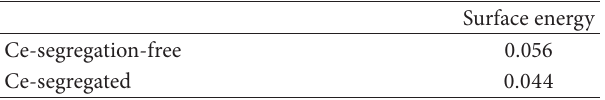
Table 1: Surface energy (in eV/A 2 ) of Ce-segregation-free and Ce- segregated CeSZ (111)